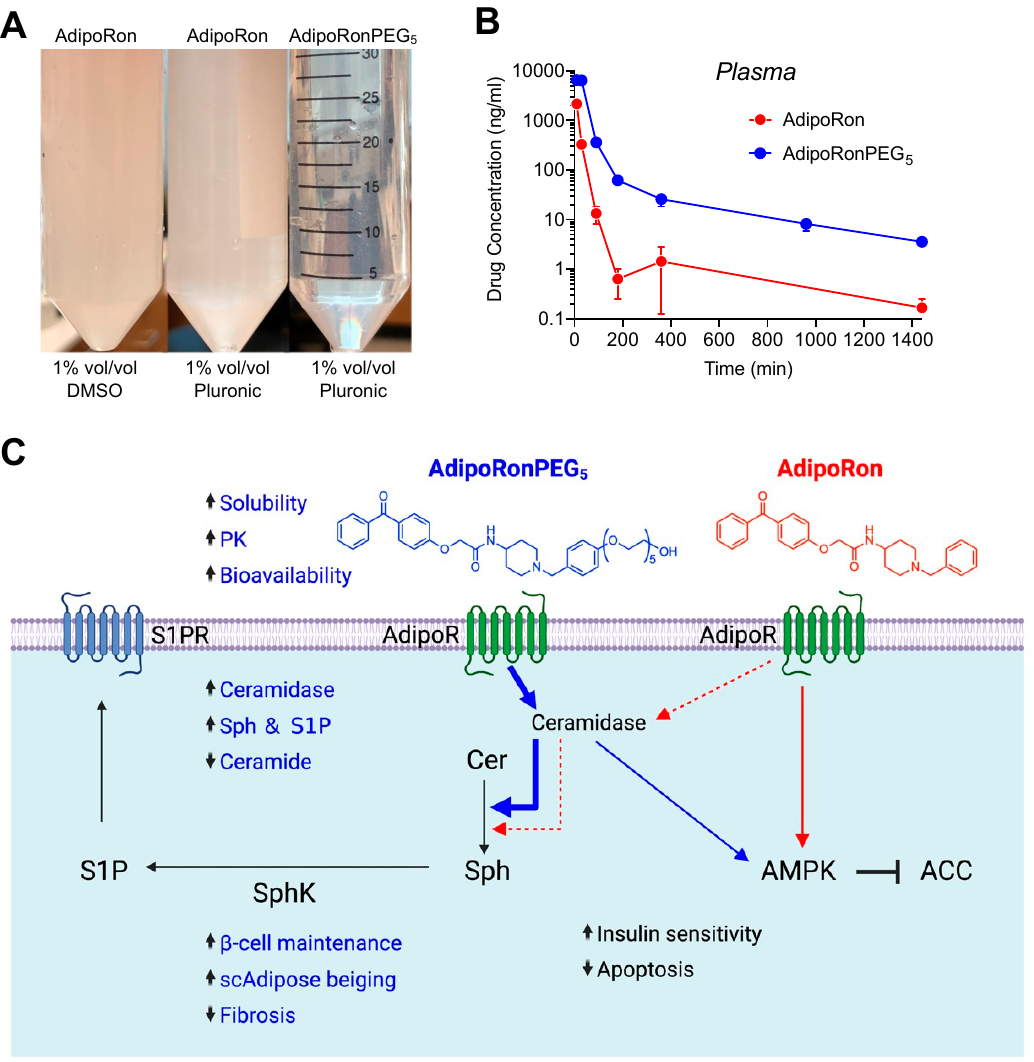
Figure 5. Pharmacological improvements of AdipoRonPEG 5 enhance its action through ADIPOR to exert pleiotropic benefits on metabolism, cell function, and survival. ( A ) Aqueous solubility of Ad- ipoRonPEG5 is drastically enhanced. ( B ) Pharmacokinetic profiles of AdipoRon and AdipoRonPEG 5 upon IP dosing at 20 mg/kg in C57BL/6J mice. ( C ) Comparison of cellular actions of AdipoRonPEG 5 and AdipoRon. Adapted from [8] with permission from Elsevier.